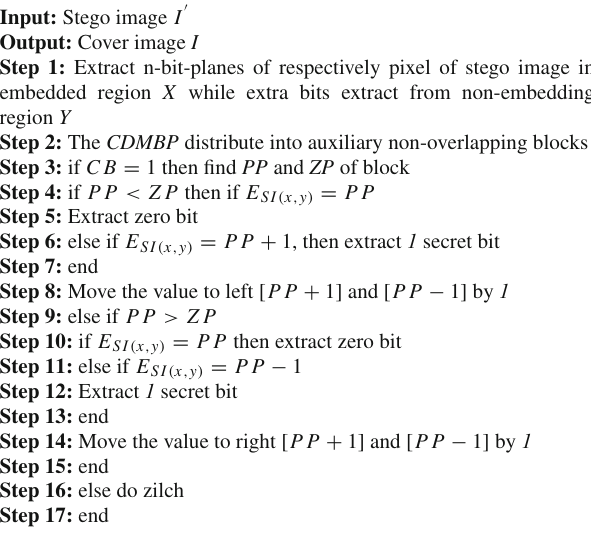
Algorithm 1 Secret bits extraction